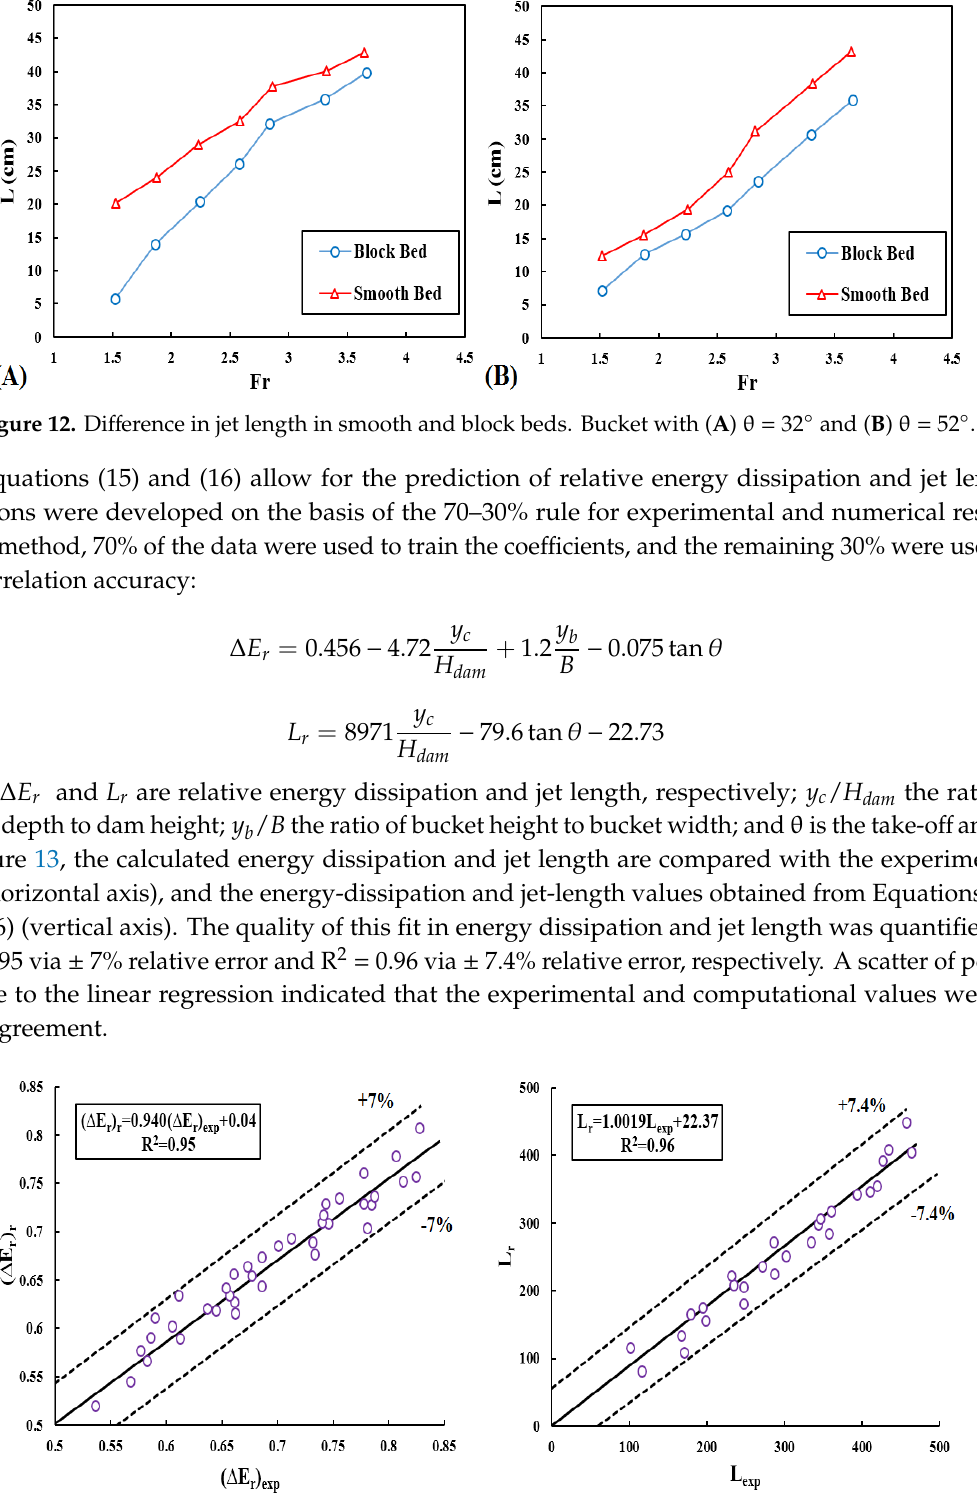
Figure 13. Comparison between observed and computational relative energy dissipation and jet length.